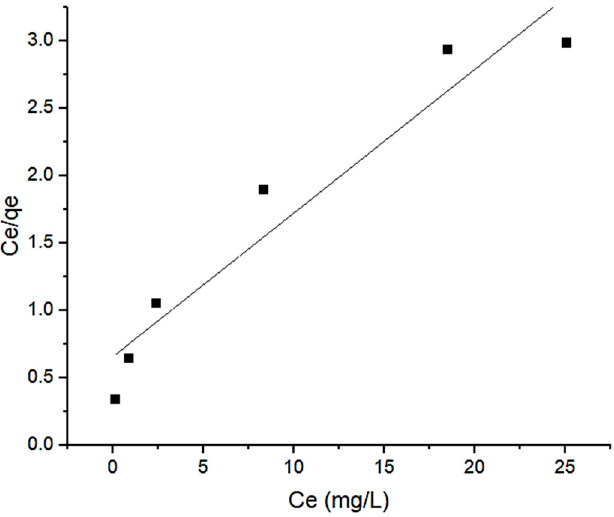
Figure 11. Langmuir isotherm for the removal of Pb(II) ions from aqueous solution by Figure 10. Langmuir isotherm for the removal of Pb(II) ions from aqueous solution by Si-TS-SSIL.